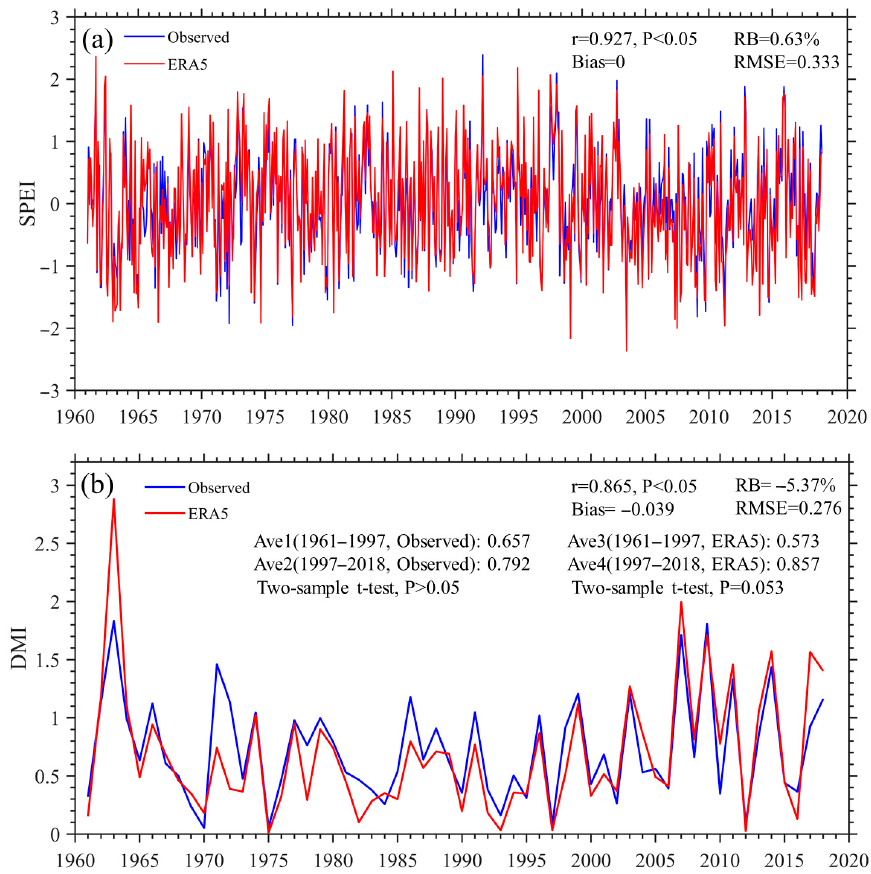
Figure 3. Temporal variations of ( a ) the 1-month SPEI and ( b ) the DMI per-year averaged GRB from 1961 to 2018.